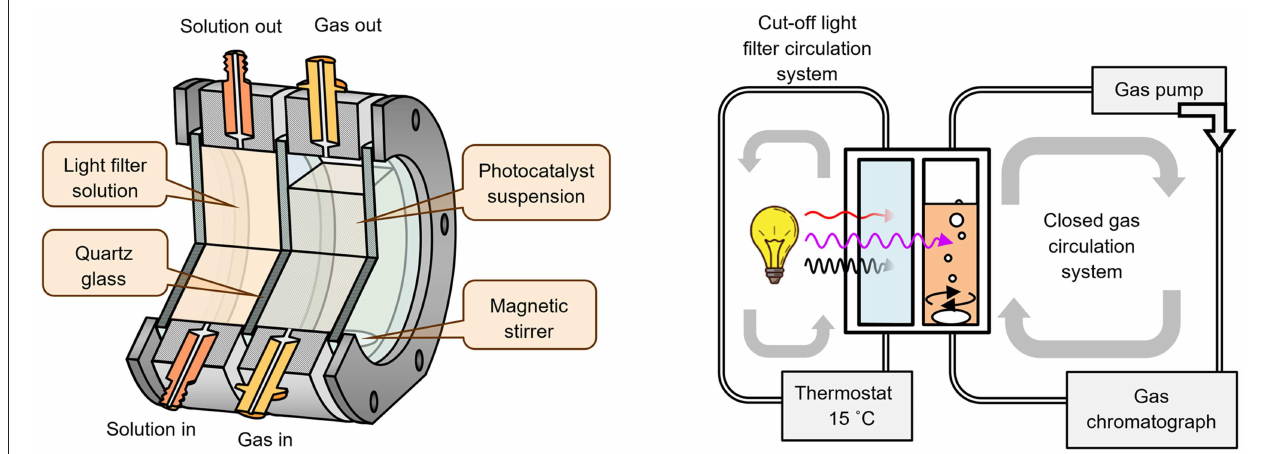
FIGURE 1 | Photocatalytic reaction cell and scheme of the photocatalytic experimental set-up.